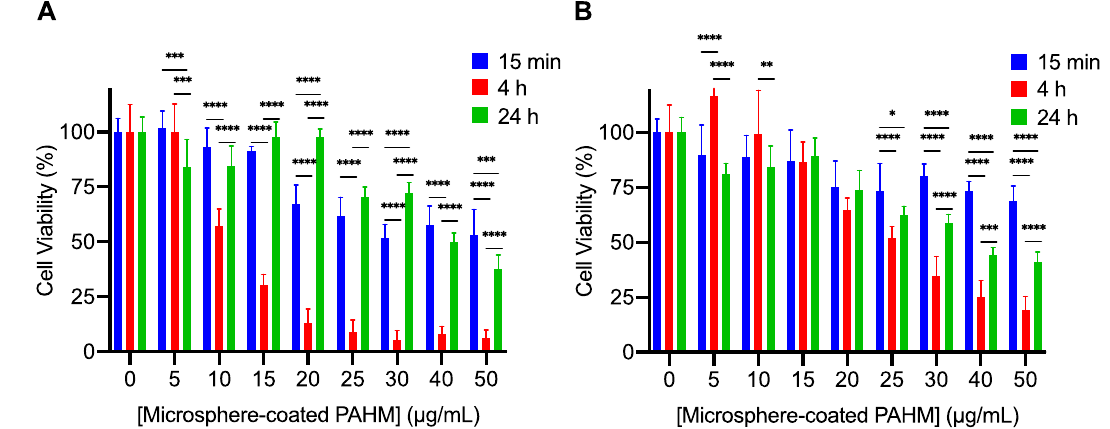
Figure 6. Cell viability after exposure to PAHM released from coated microspheres with average diameter ( A ) 71 µm ( B ) 100 µm. Data are shown as mean ± SD (n = 6–12), ANOVA with Tukey HSD test (*p < 0.05, **p < 0.01, ***p < 0.001, ****p < 0.0001).